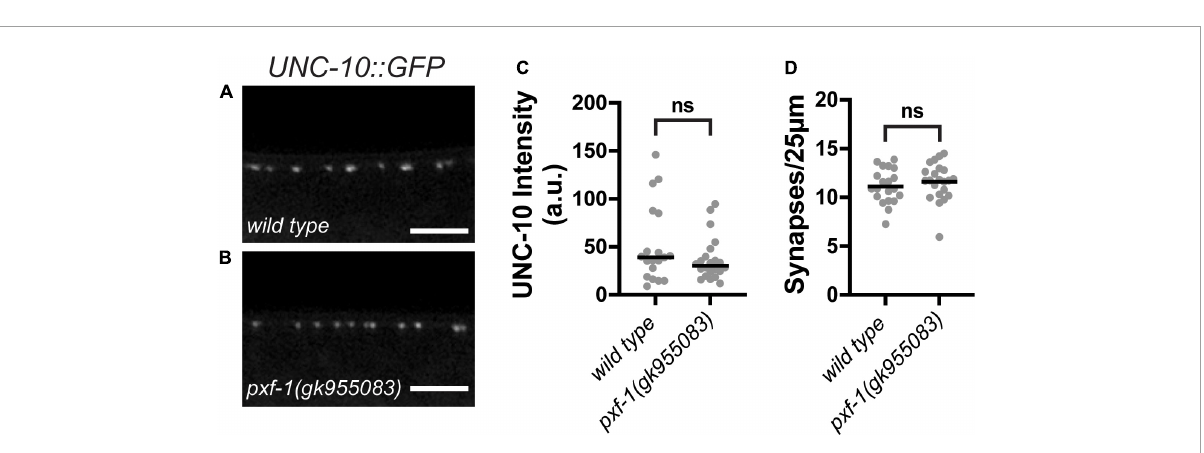
FIGURE5 PXF-1 does not influence active zones. (A,B) Representative images of UNC-10:GFP labeled acetylcholine synapses in dorsal cord of (A) wild type and (B) pxf-1(gk955083) animals. Scale bars are 5 µ m. (C) Quantification of fluorescence intensity in arbitrary units, a.u. Gray dots represent individual animals, black bars indicate medians. (D) Quantification of synaptic density. Gray dots represent individual animals, black bars indicate means. n = 19–22 animals. ns, not